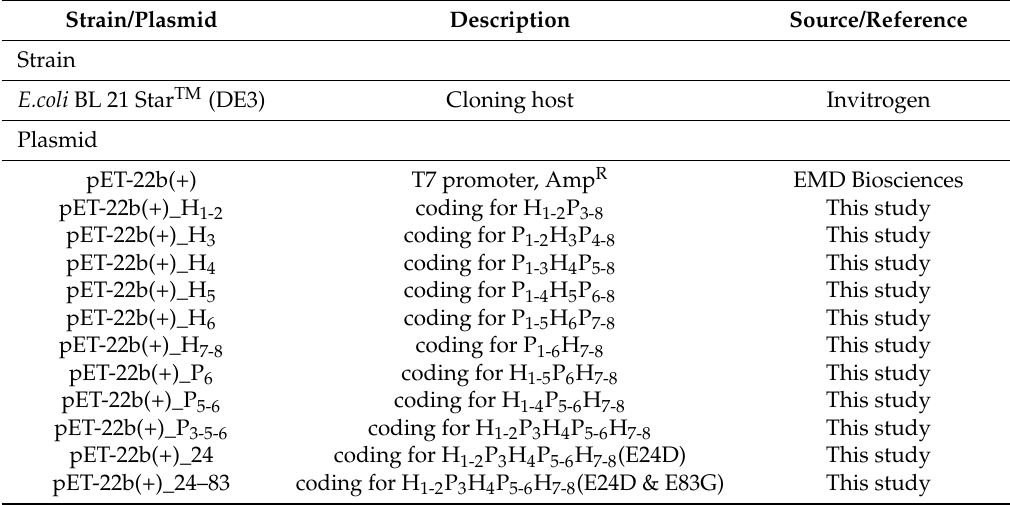
Table 2. List of plasmids and strains in this